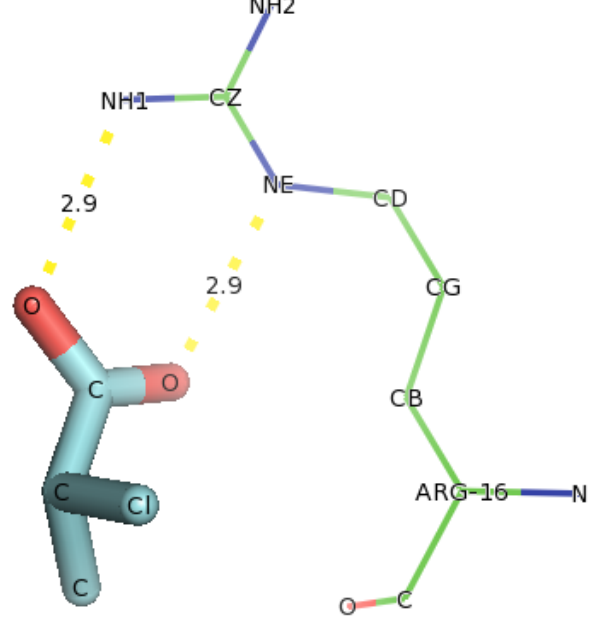
Figure 16. The interacting residues of DehD variant Y107A with D -2CP. Hydrogen bond distances are in Å.